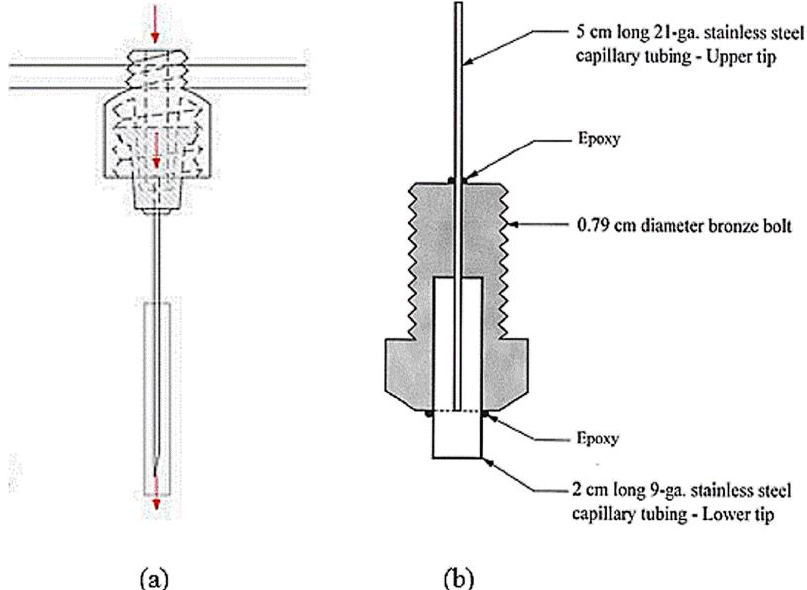
Figure 6. Drippers with threads for connection to the water tank with drippers and additional tubes for modification of their performances: ( a ) Metal tube dripper with plastic threaded adapter at the end and plastic tube at the other end [58] (Reprinted/adapted with permission from Ref. [Wang et al., 2018]); ( b ) Dripper in the form of a metal tube with a metal adapter with a thread at the end and a metal tube at the other end [80] (Reprinted/adapted with permission from Ref. [Regmi & Thompson, 2000]).